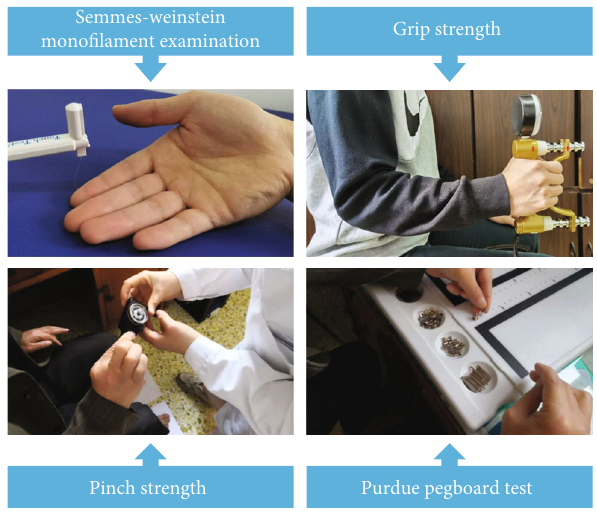
Figure 2: Illustration of hand function